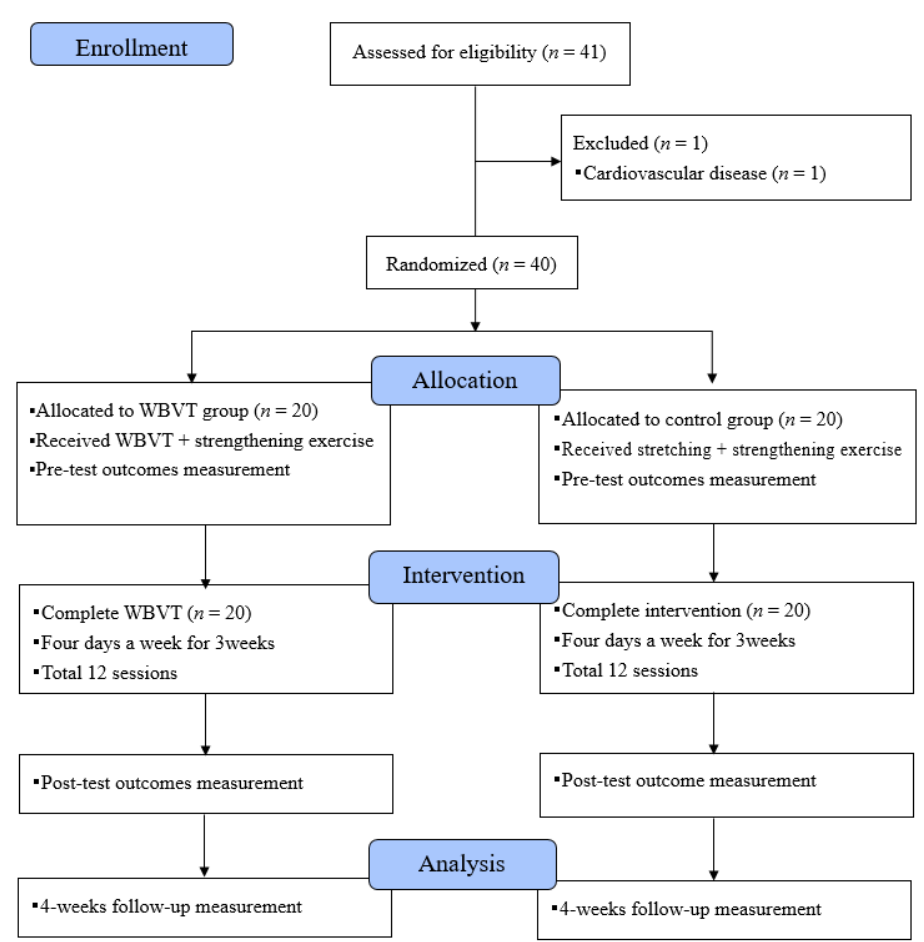
Figure 2. Participant flow diagram. Abbreviations; WPBT, whole-body vibration training. Demographic data and baseline characteristics for each group are shown in Table 1. There were no significant differences in baseline demographic between the two groups. Table 1. Comparison of baseline demographics and outcome measures between groups.